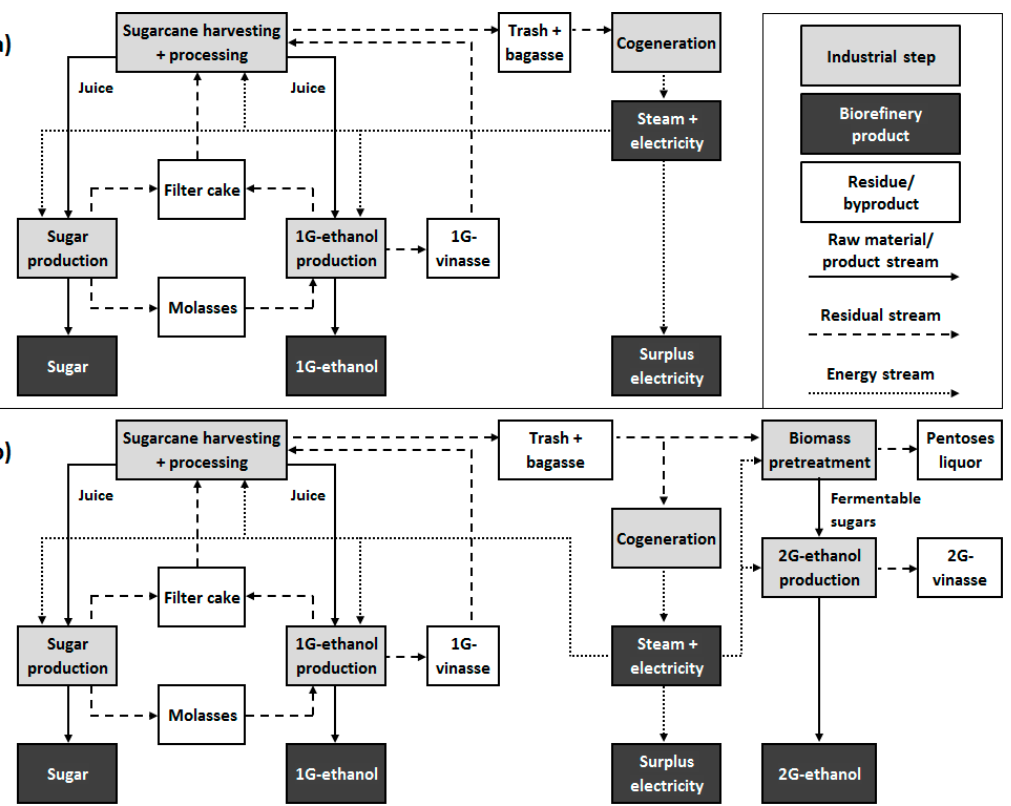
Figure 1. Generation and destination of solid and liquid residual streams in ( a ) conventional first generation (1G) and ( b ) integrated first and second generation (1G2G) sugarcane biorefineries. With respect to residual stream management from sugarcane biorefineries, two different scenarios can be observed when considering solid and liquid fractions.